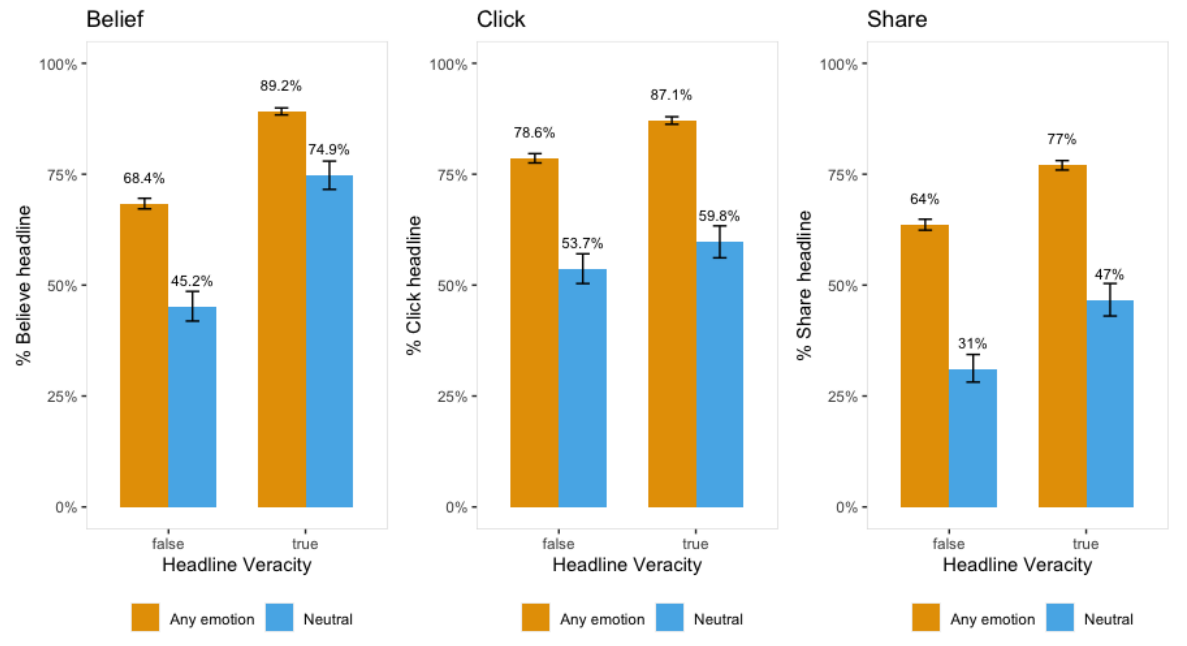
Figure 1. Rate of belief in, clicking, and sharing of headlines by true/false headline veracity and respondents’ emotional reaction. Blue bars indicate headlines where respondents reported feeling no emotion at all (neutral). Orange bars indicate headlines where respondents reported feeling any of the six distinct emotions presented (anger, fear, sadness, happiness, surprise, and disgust). Error bars represent 95% confidence